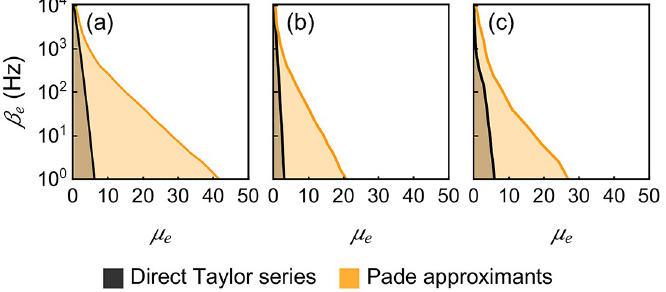
Fig 3. Convergent parametric regimes. These figures show the comparisons of the convergent parametric regimes for the direct Taylor series summation and Pade´ approximants summation. The convergence regimes are shaded in different colors and their envelope curves are shown. The vertical axis is in log scale. The convergence of each , μ ) is determined by whether or not the computed β value is within one standard deviation of the parametric point ( β e e simulated β value. In panel (a), h = 1 Hz, a = 0.1; in panel (b) h = 1 Hz, a = 0.2; in panel (c) h = 50 Hz, a = 0.1. Parameters: τ = 10